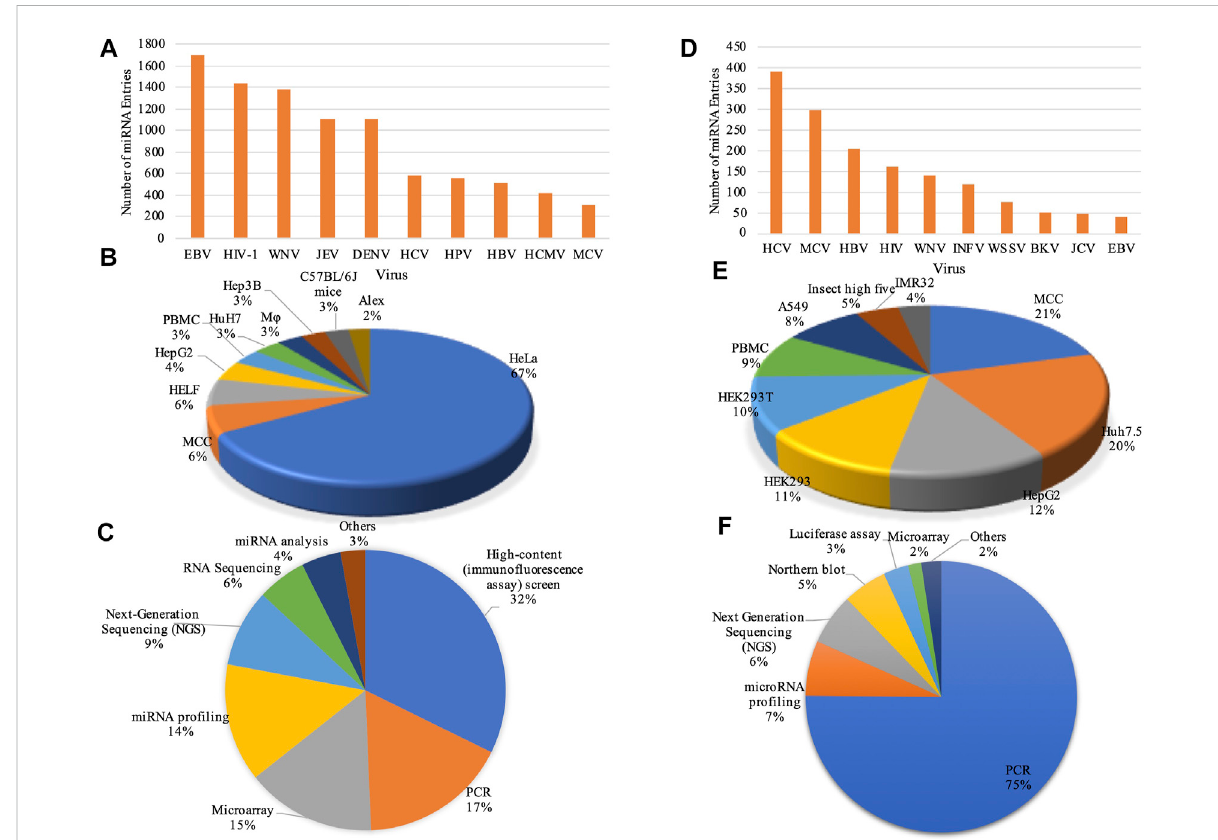
FIGURE 2 Data statistics: Bar graphs represent the number of entries in top 10 viruses for (A) ‘ DEmiRVIR ’ and (D) ‘ AntiVmiR ’ . Pie charts representing statisticaldistributionofcelllinesin (B) ‘ DEmiRVIR ’ and (E) ‘ AntiVmiR ’ andexperimentalmethodsin (C) ‘ DEmiRVIR ’ and (F) ‘ AntiVmiR ’ (HCV,HepatitisC virus; MCV, Merkel cell polyomavirus; HBV, Hepatitis B virus; HIV, Human immunode fi ciency virus; WNV, West Nile Virus; INFV, In fl uenza A virus; WSSV, White spot syndrome virus; BKV, BK polyomavirus; JCV, JC polyomavirus; EBV, Epstein Barr virus; JEV, Japanese encephalitis virus; DENV, Dengue virus; HPV, Human papillomavirus and HCMV, Human